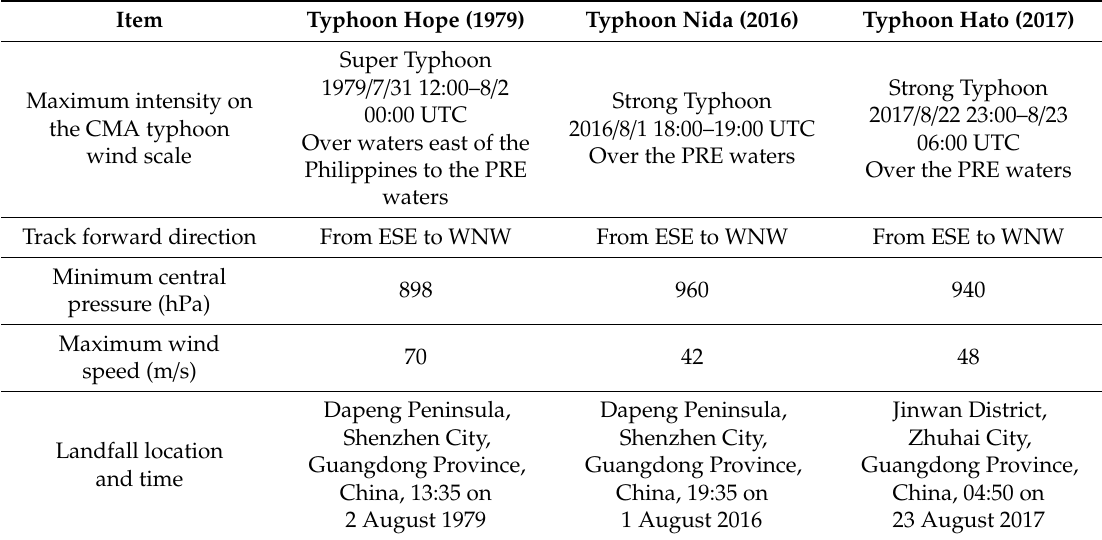
Table 1. Basic information for Typhoon Hope, Typhoon Nida, and Typhoon Hato provided by the China Meteorological Administration